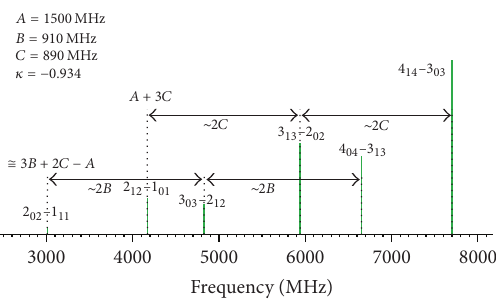
-branch transition patterns. Two sequences are shown, �rstly the transitions with approximate general formula , and secondly the transitions with approximate general formula